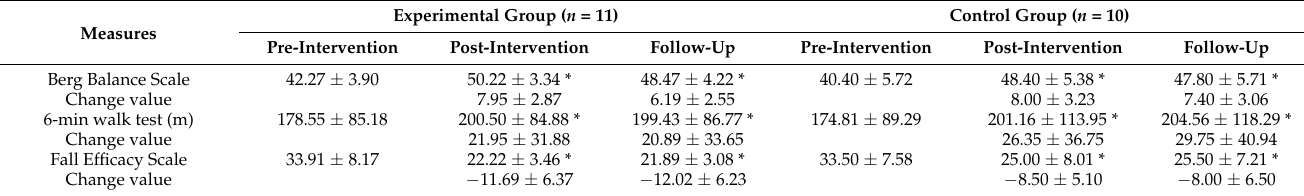
Table 3. Comparisons of balance, endurance, and concern about